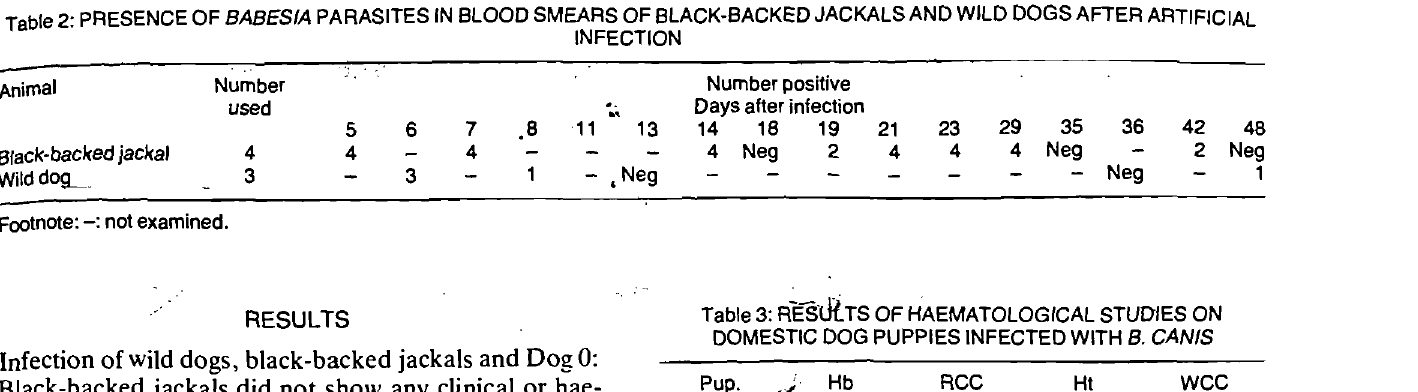
Table 3: RESdi TS OF HAEMATOLOGICAL STUDIES ON DOMESTIC DOG PUPPIES INFECTED WITH B. CANIS Pup.